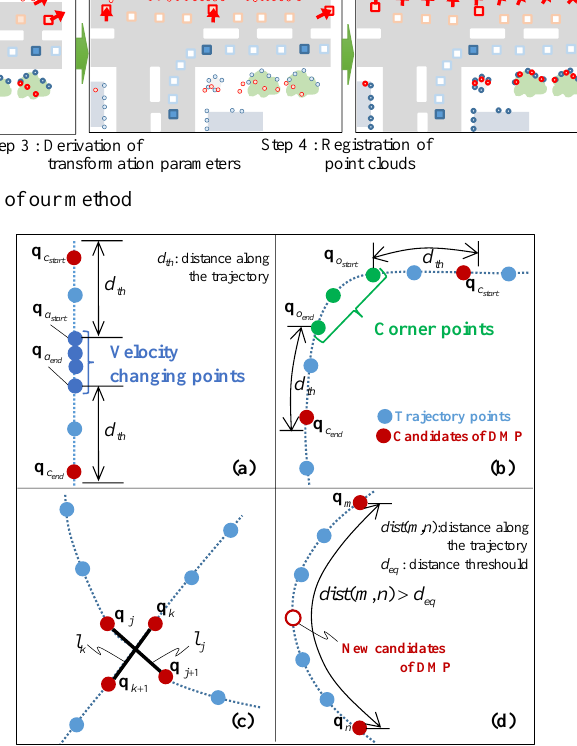
Figure 2. Selecting Candidates of DMP